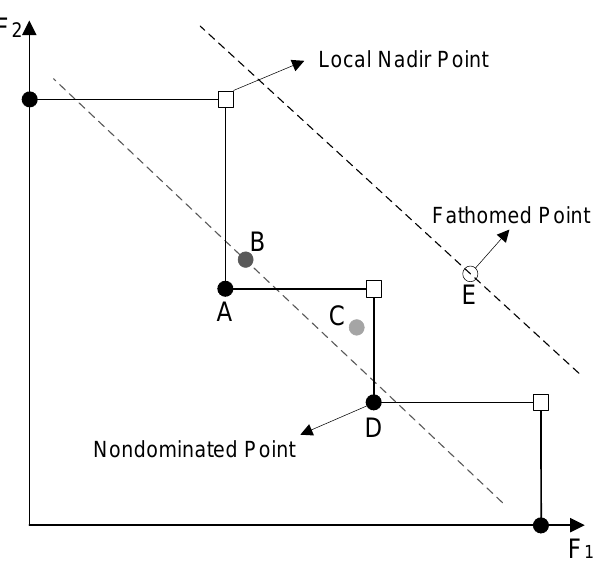
Figure 3. An example of fathoming